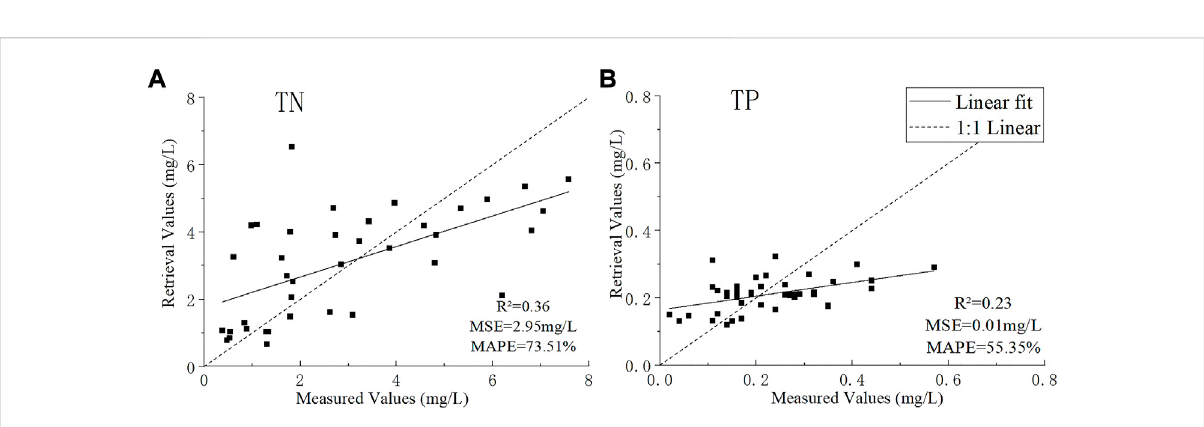
FIGURE 8 PerformanceevaluationoftheoptimalTNandTPretrievalmodelswhichdidnotusethegeographicdivisionstrategy. (A) TNretrievalmodel; (B) TP retrieval